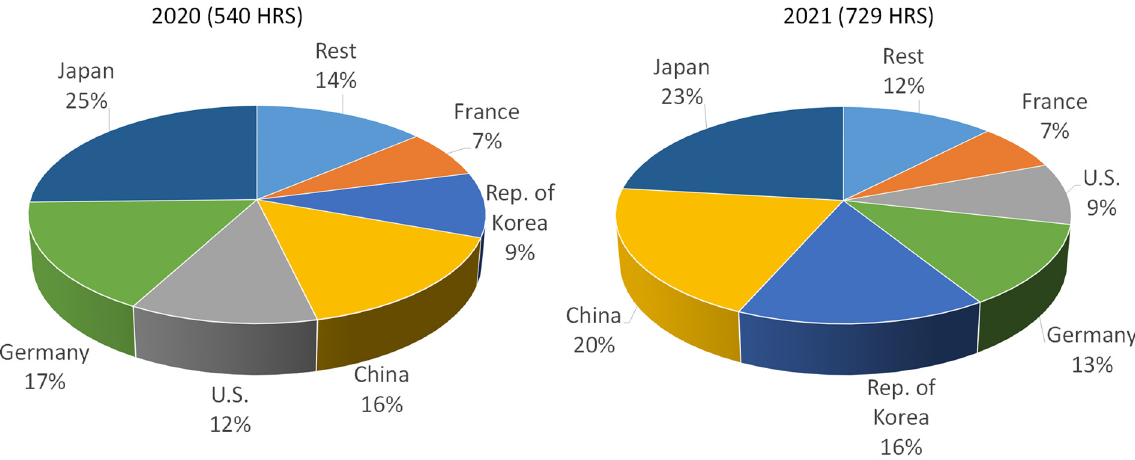
Figure 13. HRSs in the top six countries with more than 50 stations in operation as of the end of 2021: change of shares 2020–2021.